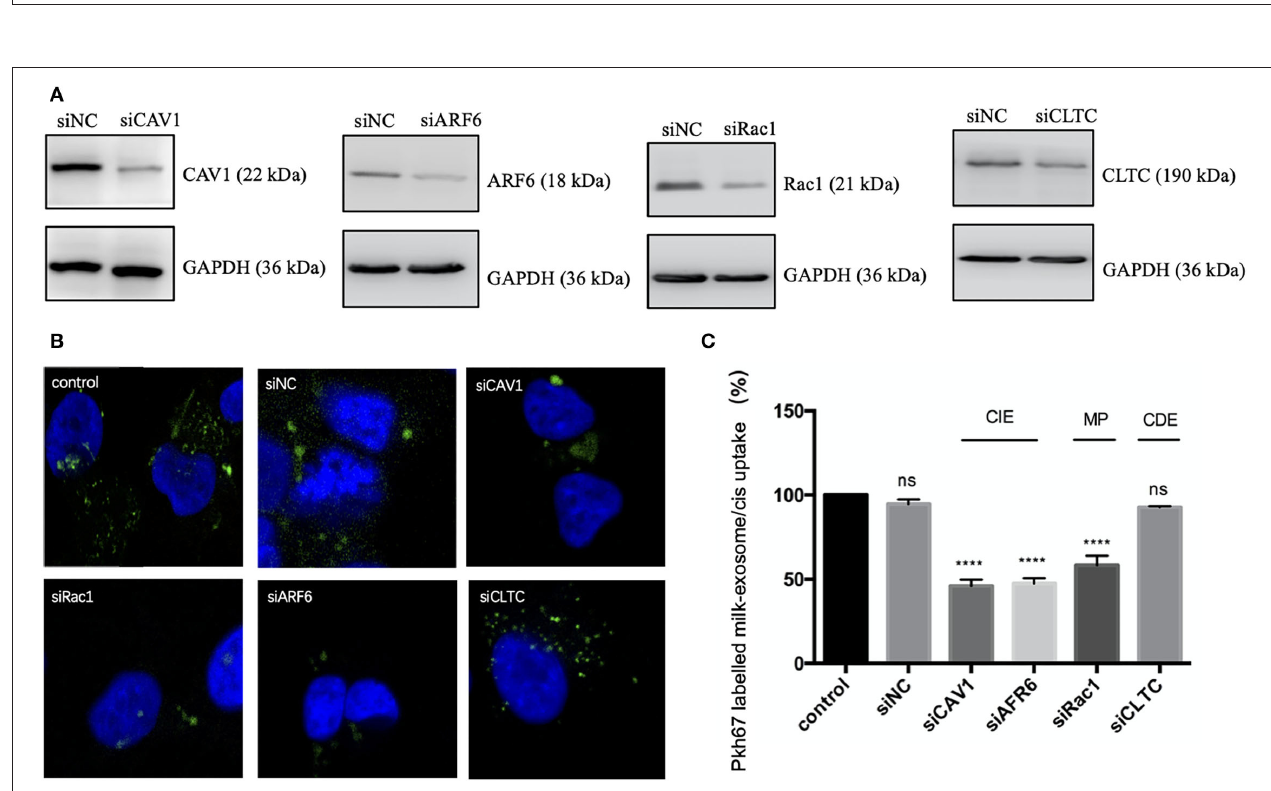
FIGURE 7 | Analysis of the influence of CAV1, ARF6, Rac1 or CLTC upon inhibiting pkh67 labeled milk-exosome/cis internalization via knockdown technology. (A) Western Blot analysis of A2780CP cells transfected with siRNA against key endocytic regulators caveolin-1 (CAV1), ARF6 and Rac1 and clathrin heavy chain (CLTC), or negative control siRNA (NC). (B,C) Pkh67 labeled milk-exosome/cis (green spots) uptake by A2780CP cells (blue fluorescence DAPI labeled nuclei) pretreated with indicated siRNAs, as visualized and quantified by confocal microscopy (C) . Values represent mean ± S.E.M. ****, P < 0.0001. ns, no significance.